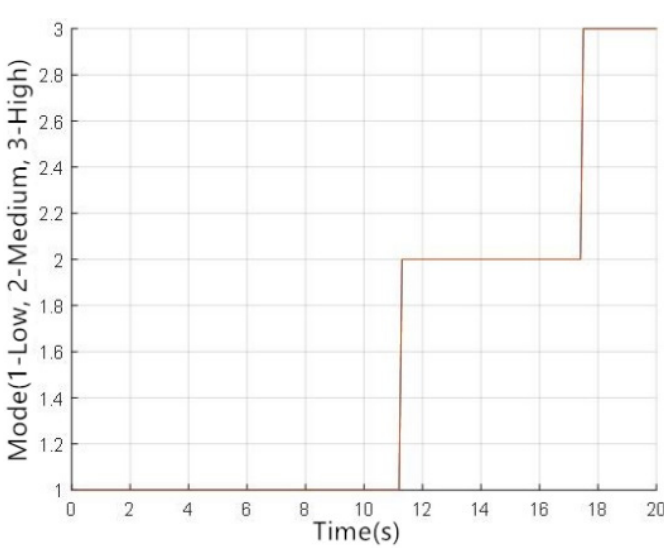
Figure 15. Pressure regulation mode curve of PBC.